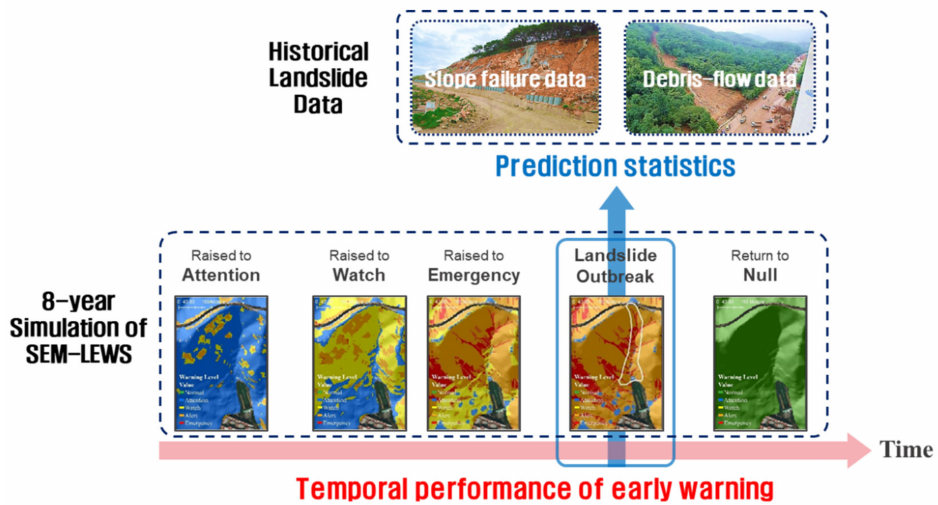
Figure 5. Performance analysis framework of the landslide early warning system for Busan applying the sequential evaluation